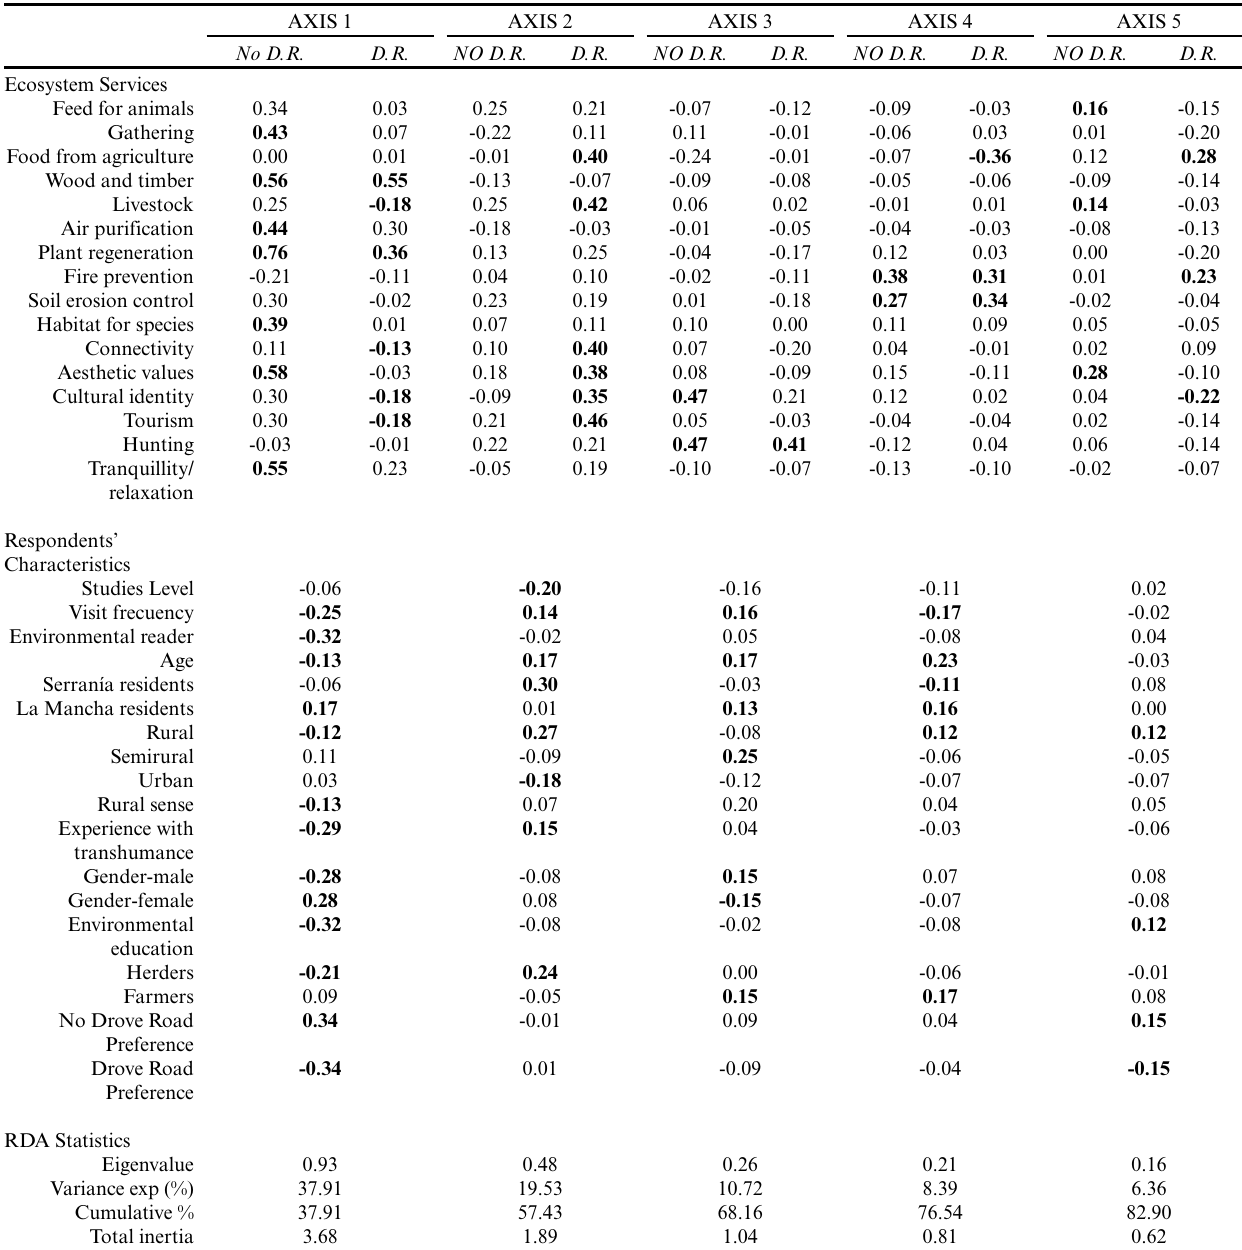
Table 2 . Redundancy analysis results for the cropland landscape, showing the factor scores of ecosystem services and the variables related to the socioeconomic characteristics of the respondents. Eigenvalues, percentage of variance explained, cumulative percentage of variance explained, and inertia by axes (1–5) are also indicated. Bold values indicate the variables with the largest squared cosine in each of the axes. Note: D.R. = drove